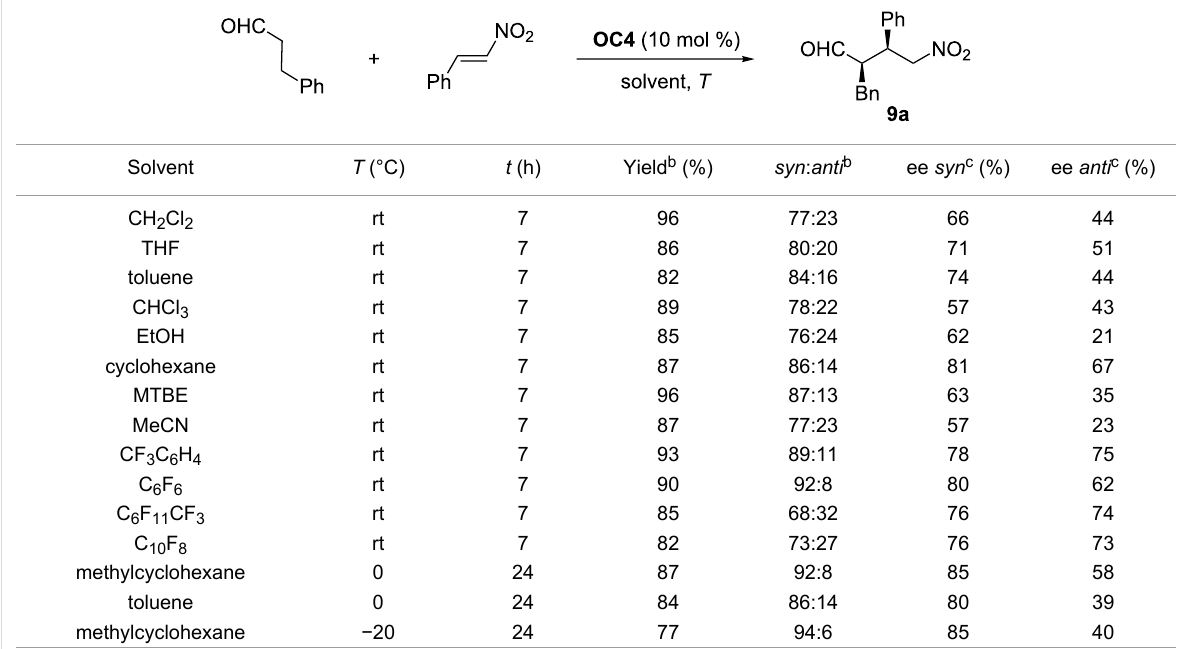
Table 2: Optimization of the reaction conditions for the Michael addition of 3-phenylpropionaldehyde to trans - β -nitrostyrene using catalyst OC4 .